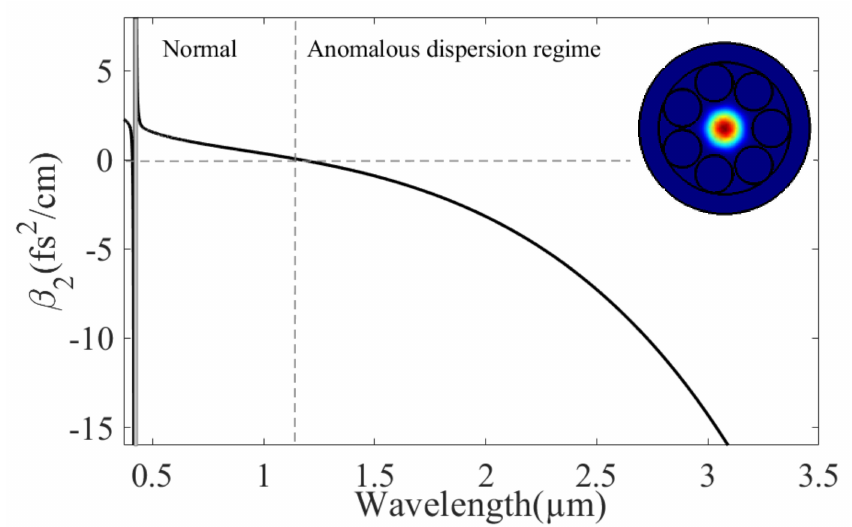
Figure 1. Group velocity dispersion as a function of the wavelength for the HC-PCF filled with argon at a pressure of 5 bar. The grey area represents the resonant band. The inset represents a schematic view of the fiber with the LP 01 mode at 1030